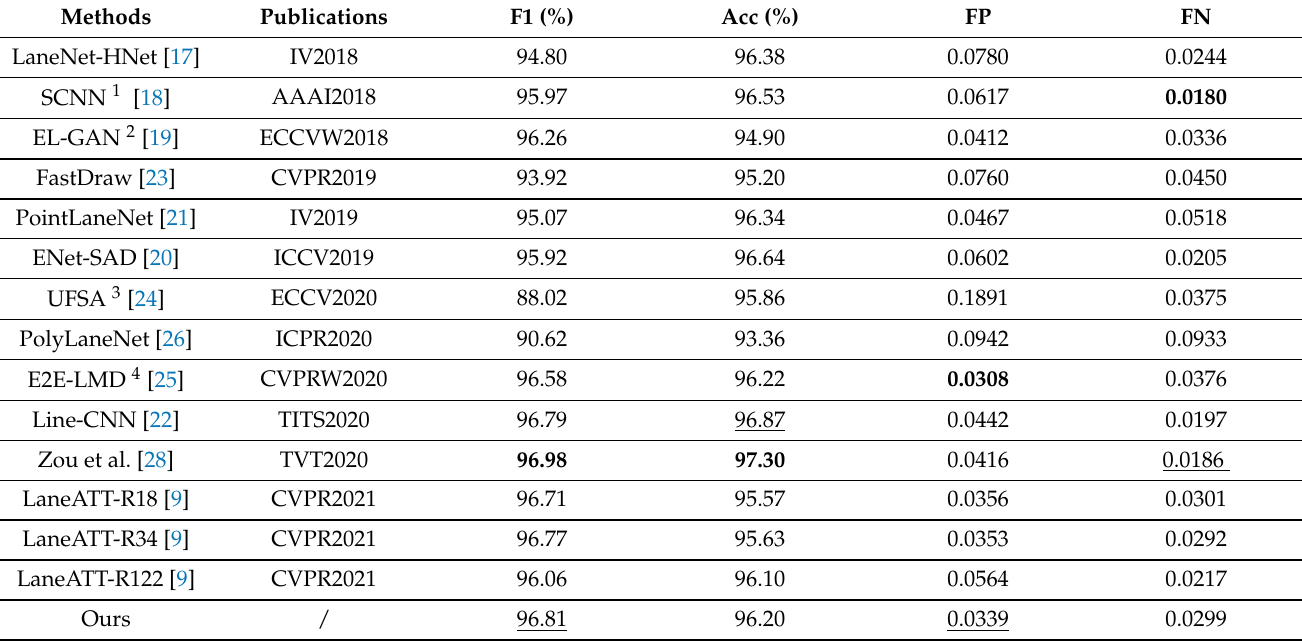
Table 5. Comparison with other state-of-the-art methods on the Tusimple